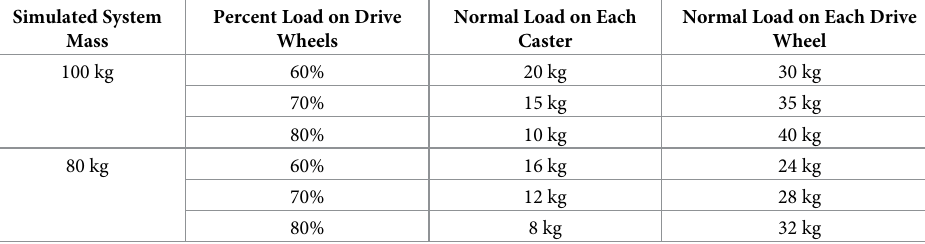
Table 1. Description of system masses and weight distributions. The values in these columns represent the typical loading experienced by each component during coast-down and scrub torque tests. Simulated System